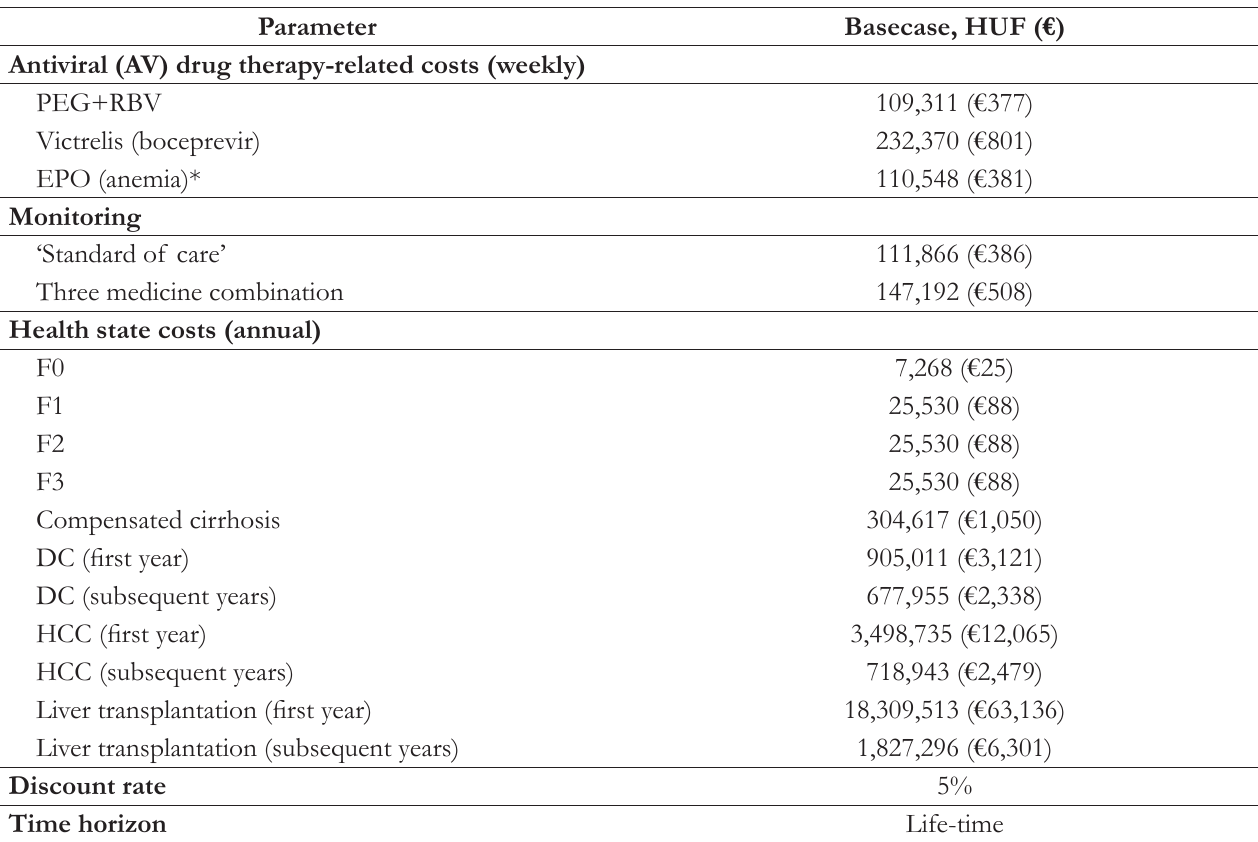
Table 6. Cost Data Used in the